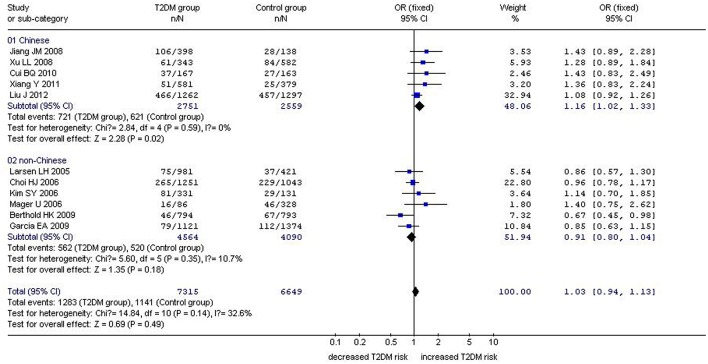
Forest plot of T2DM associated with GHRL gene Leu72Met (L72M) polymorphism under an additive genetic model (M vs. L). Under the additive genetic model, no significant correlation was found (OR: 1.03, 95% CI: 0.94–1.13, P = 0.14). A significant correlation between them was found (OR: 1.16, 95% CI: 1.02–1.33, P = 0.02) in the Chinese population. No significant correlation was detected in the non-Chinese population (OR: 0.91, 95% CI: 0.80–1.04, P = 0.18).